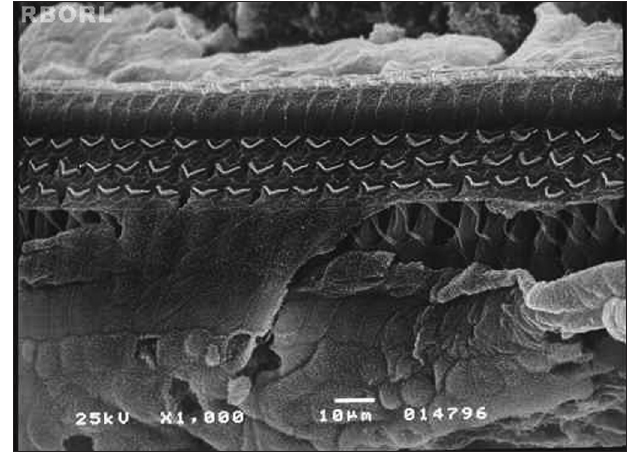
Figura 1. Fotomicrografia de órgão de Corti normal encontrado em cobaia do grupo 1, demonstrando espira basal. Observe estruturas não lesionadas em A: extensão digital da células de Deiter; B: células ciliadas externas; C: estereocílios das células ciliadas externas; D: membrana reticular. Ampliação 1000x.